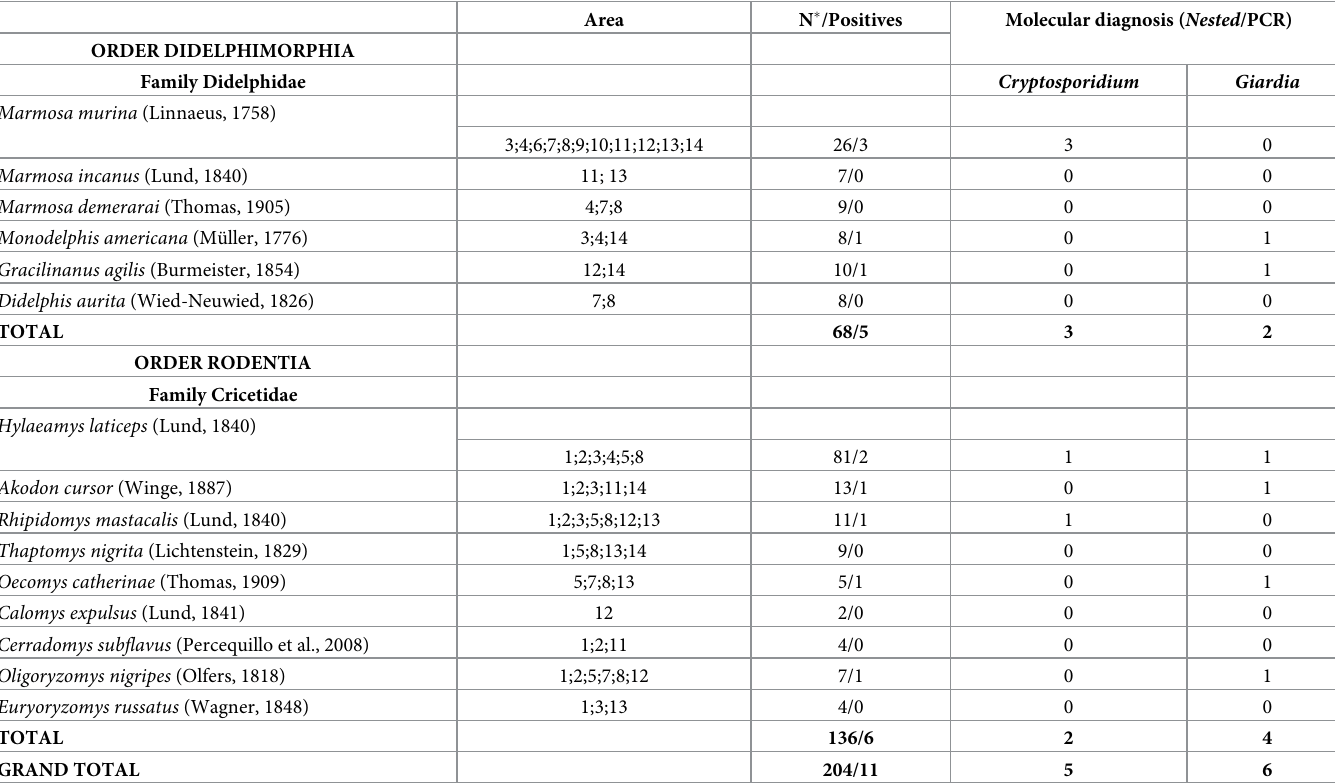
Table 1. Species of marsupials and wild rodents captured in the Atlantic Forest and Cabruca areas in southern Bahia, northeastern Brazil, and positivity of infected